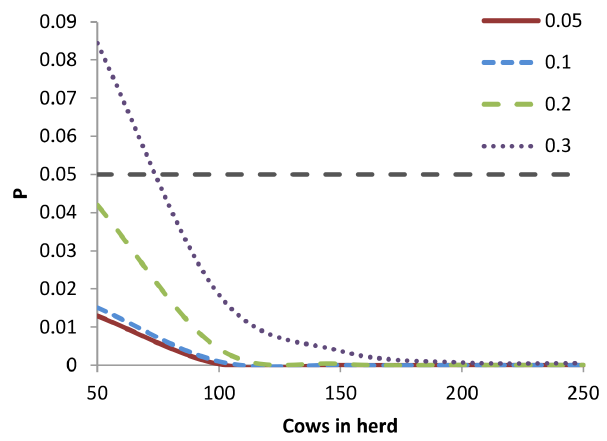
Figure 10. Herd size and the predicted difference in numbers of c IFN and SICCT false positives. The probability of a null hypothesis stating that c IFN and SICCT give an equal amount of false positives being true is given for herds containing 50–250 cows. The coloured lines represent different levels of BTB prevalence in the herd, the value of which is given; the dotted line gives the a =0.05 significance level. Only in very small herds, at high prevalence levels, is SICCT projected not to significantly outperform c IFN.